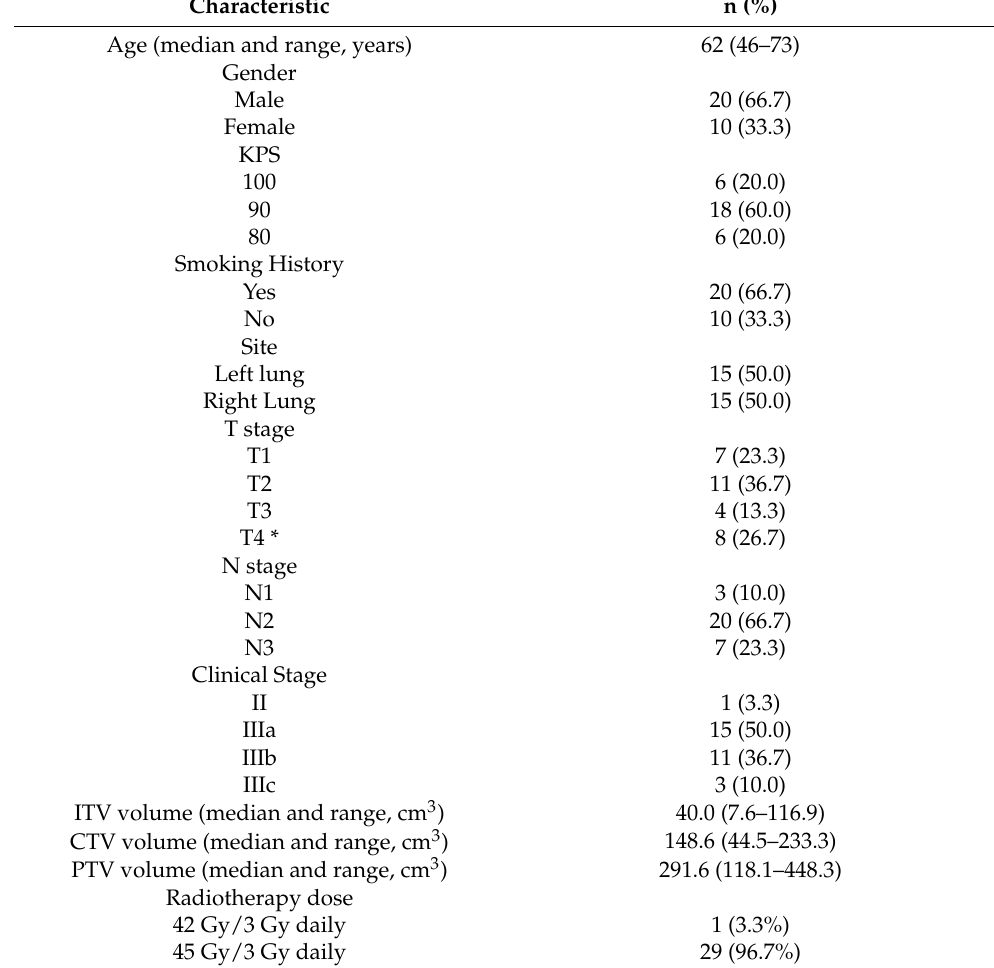
Table 1. Baseline data of